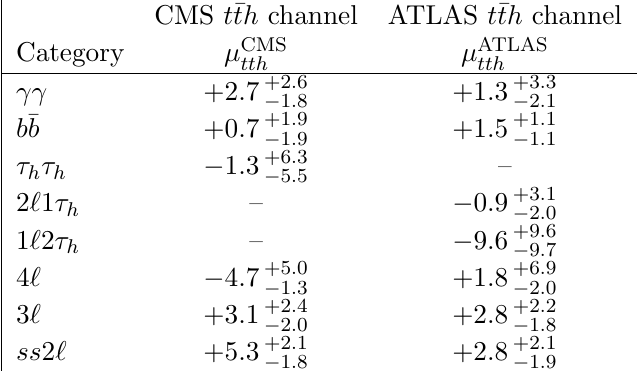
and (cid:22) ATLAS coming tth tth